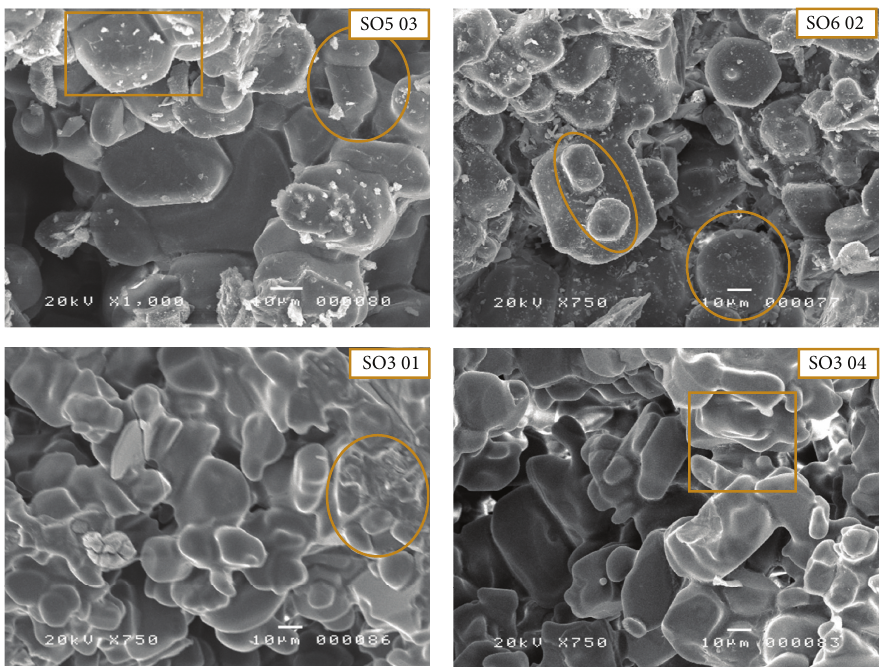
Figure6:Scanningelectronmicrographshowsdifferentmorphologiesofbeliteandaluminateminerals(C2SandC3A)foundinwhiteclinker (belite: SO5 03 and SO6 02; aluminate: SO3 01 and SO3 04).